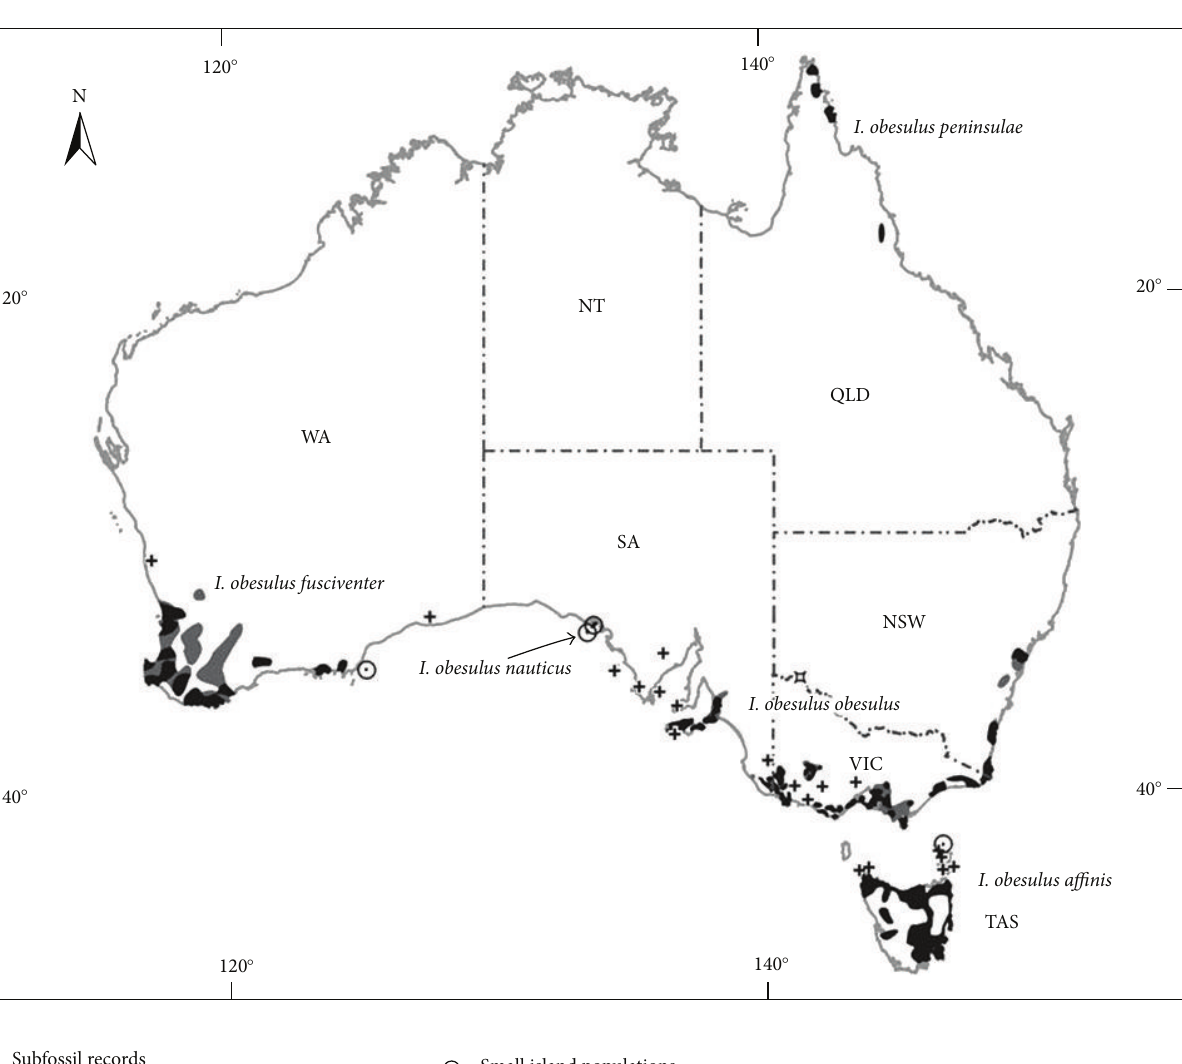
Figure 1: Distribution of Isoodon obesulus . Adapted from Rees and Paull [17] and Pope et al. [21]. Originally compiled by Rees and Paull [17] from distribution records published by Ashby et al. [11], Friend [22], Gordon et al. [23], Hocking [24], Kemper [14], Menkhorst and Seebeck [18], and Paull [19]. NSW: New South Wales, NT: Northern Territory, SA: South Australia, TAS: Tasmania, QLD: Queensland, VIC: Victoria, WA: Western